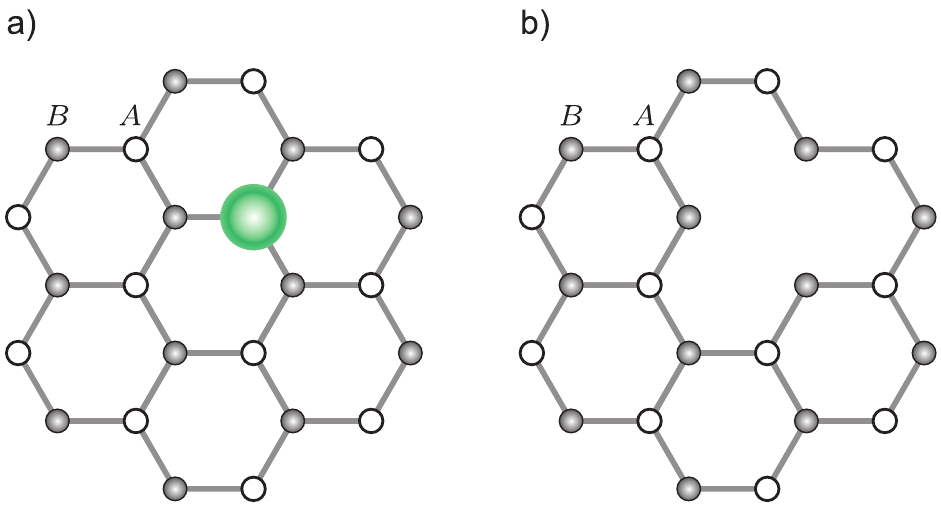
Figure 2. Single-node doping in graphene, ( a ) a new atom instead of a carbon atom, ( b ) a gap in the graphene